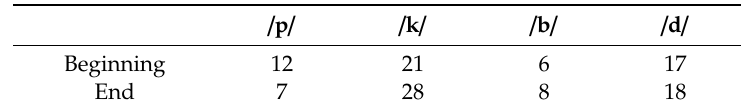
Table A1. Token counts for consonant measurements used to assess changes in production of voiceless and voiced consonants by Informant A in Sections 4.1.1 and